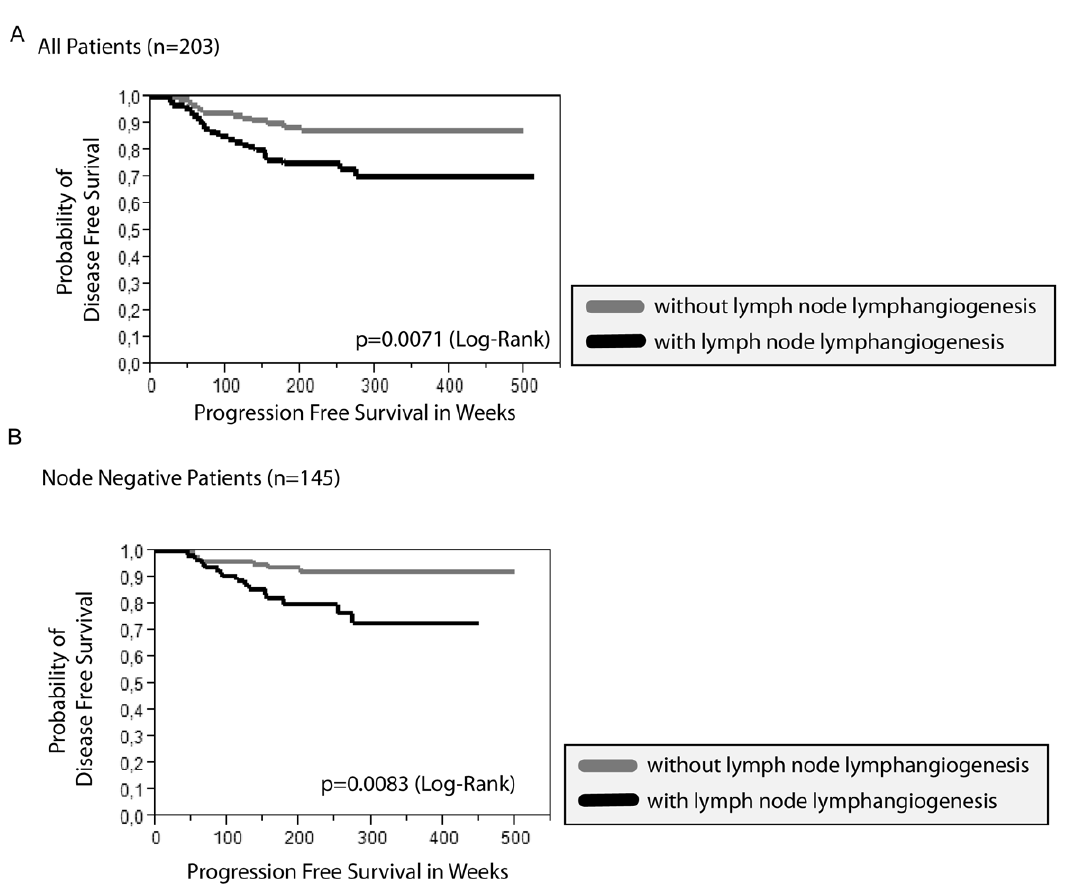
Figure 4. Lymph node lymphangiogenesis (nLV + ) and its correlation with clinicopathological parameters and time to progression. ‘‘With lymph node lymphangiogenesis’’ is defined as at least one regional/mesorectal lymph node with detectable lymphangiogenesis in the follicular or interfollicular area. A. Time to progression in weeks in relation to the probability of disease free survival stratified for the presence of lymph node lymphangiogenesis in all patients. B. Time to progression in weeks in relation to the probability of disease free survival stratified for the presence of lymph node lymphangiogenesis in node negative patients.